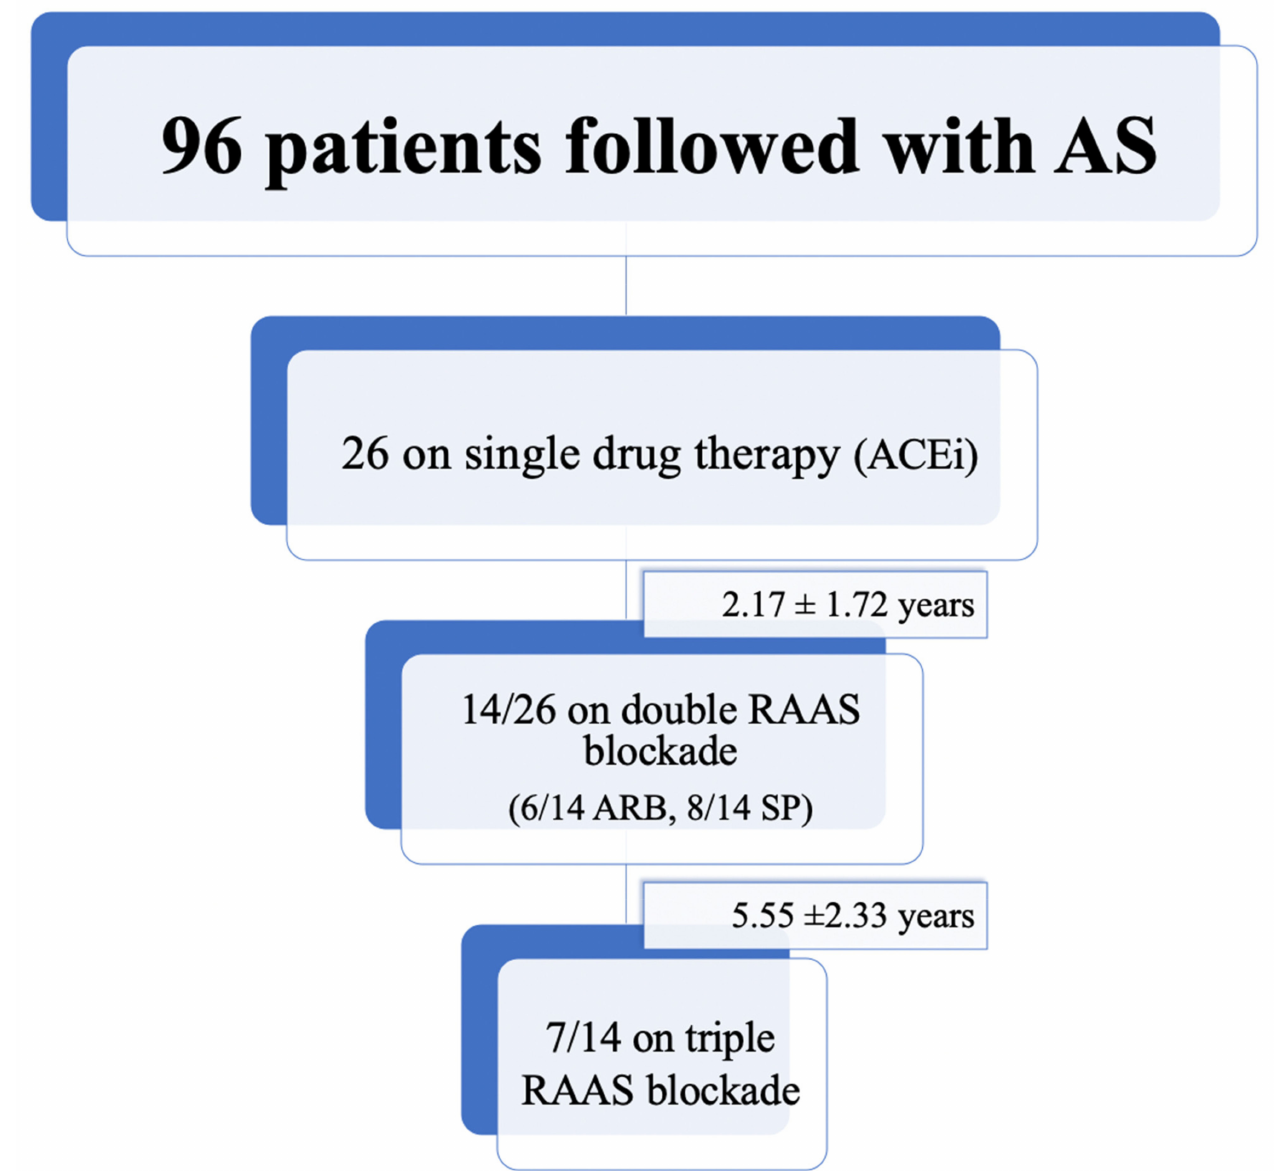
Figure 1. Flowchart relating to patients recruited from the whole cohort and group configuration. All patients received at least one RAAS blocker at the time of recruitment. In particular, 26/26 patients were on ACEi (single RAAS blockade), 14/26 (53.8%) were also on ARB (6/14) or SP (8/14), and 7/26 (26.9%) were on triple RAAS